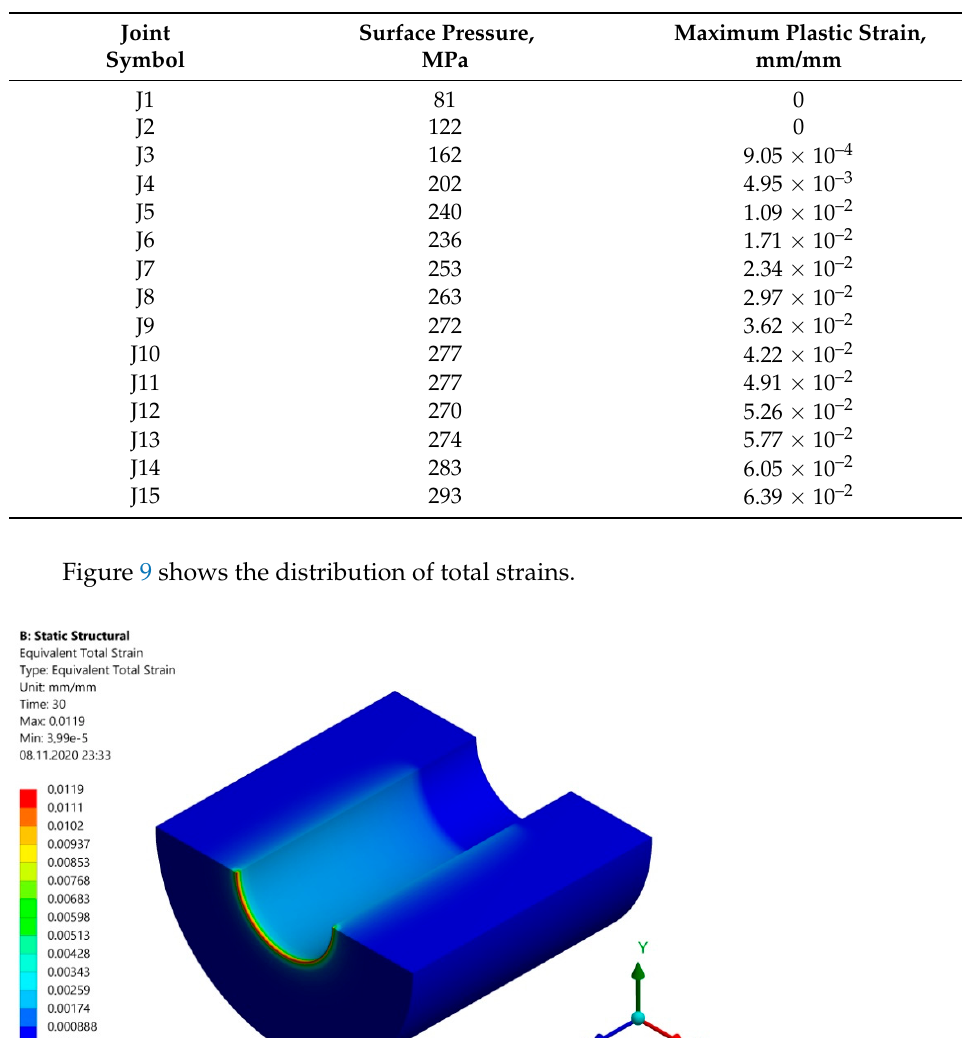
Table 3. Surface pressures and plastic strains were obtained from the FEM analysis.